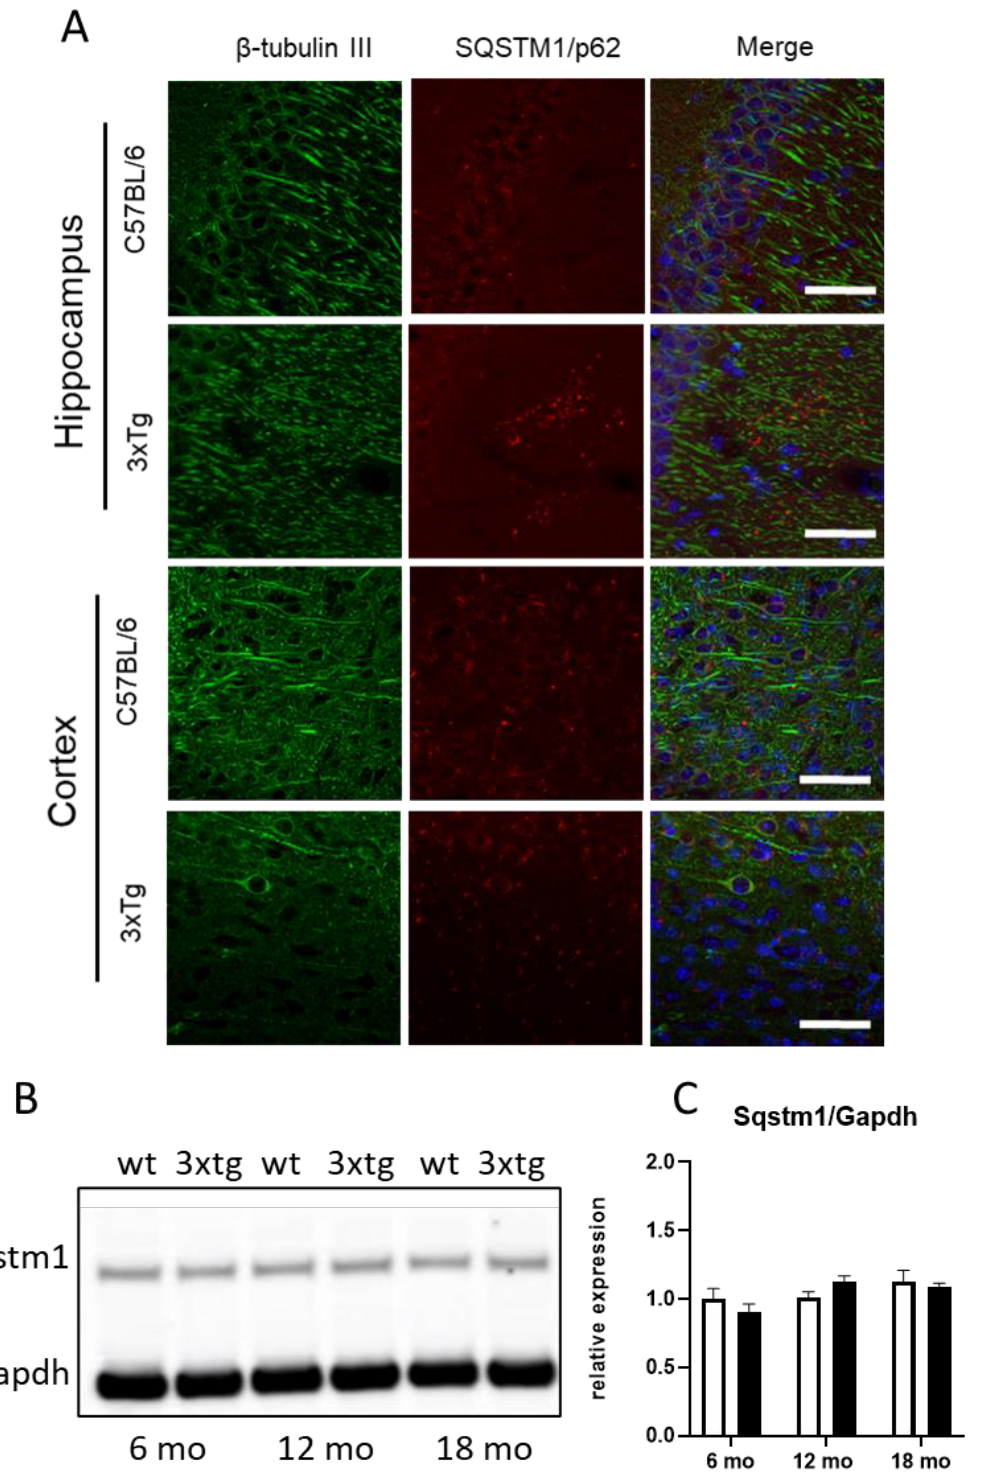
Figure 2. Sqstm1 and β -Tubulin III immunoreactivity in hippocampal and cortical sections of wild- type or 3xTg-AD mice at 12 months; scale bar: 20 µm ( A ). Sample Sqstm1 immunoblot ( B ). Sqstm1 levels in 3xTg-AD (3xTg) or wild-type (wt) mice at 6, 12, and 18 months (mo) of age ( C ). The means + SEM are plotted; n = 6/group.